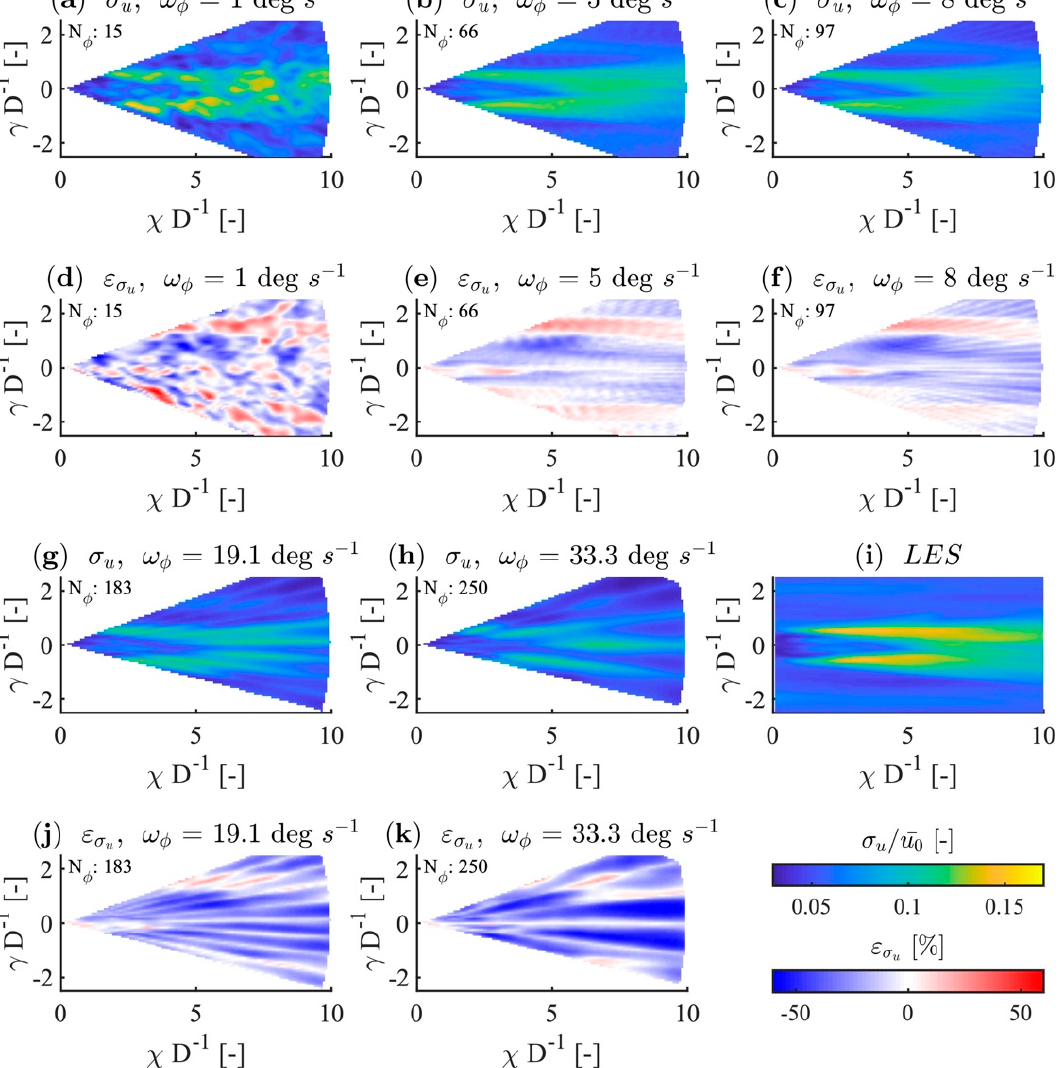
) from ( i ) the ) from ( i ) the u (cid:3296)